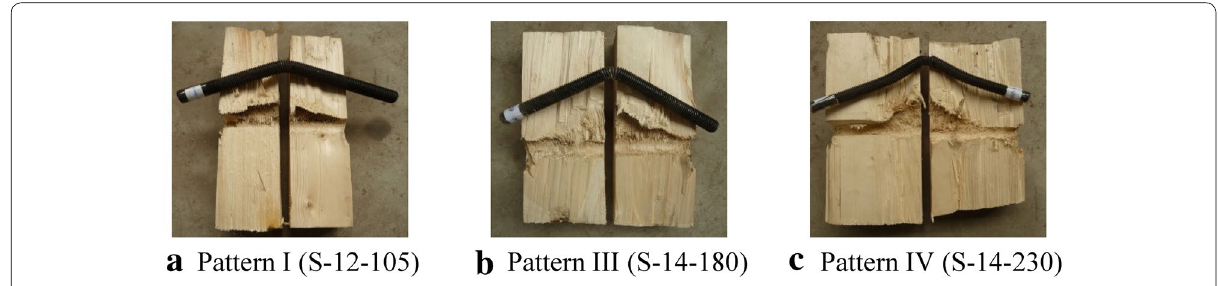
Fig. 5 Joint failure